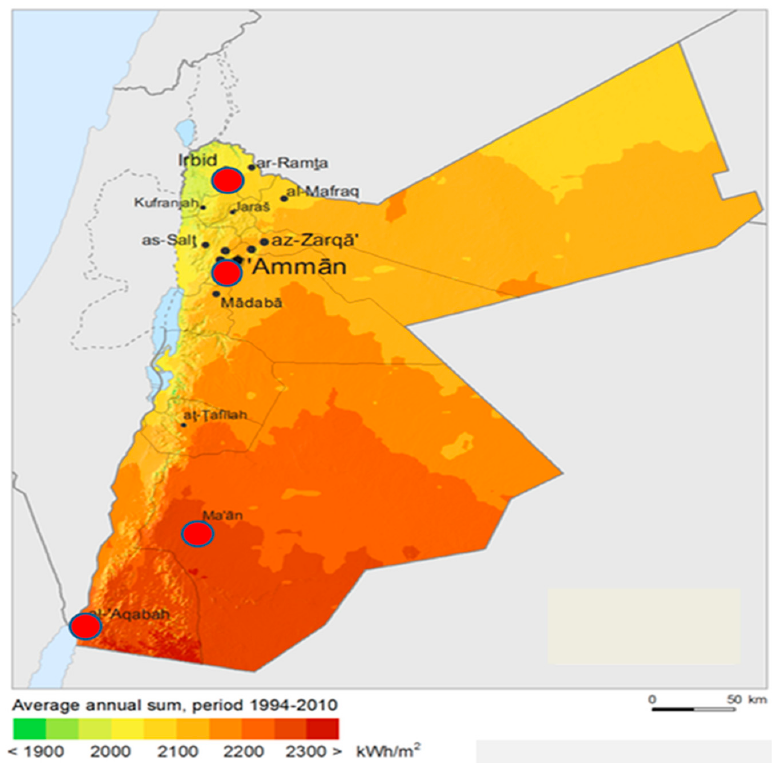
Figure 4. The selected cities and the solar radiation intensity (global horizontal irradiation) for dif- ferent regions in Jordan (solarGIS 2021 Geomodel solar). different regions in Jordan (solarGIS 2021 Geomodel